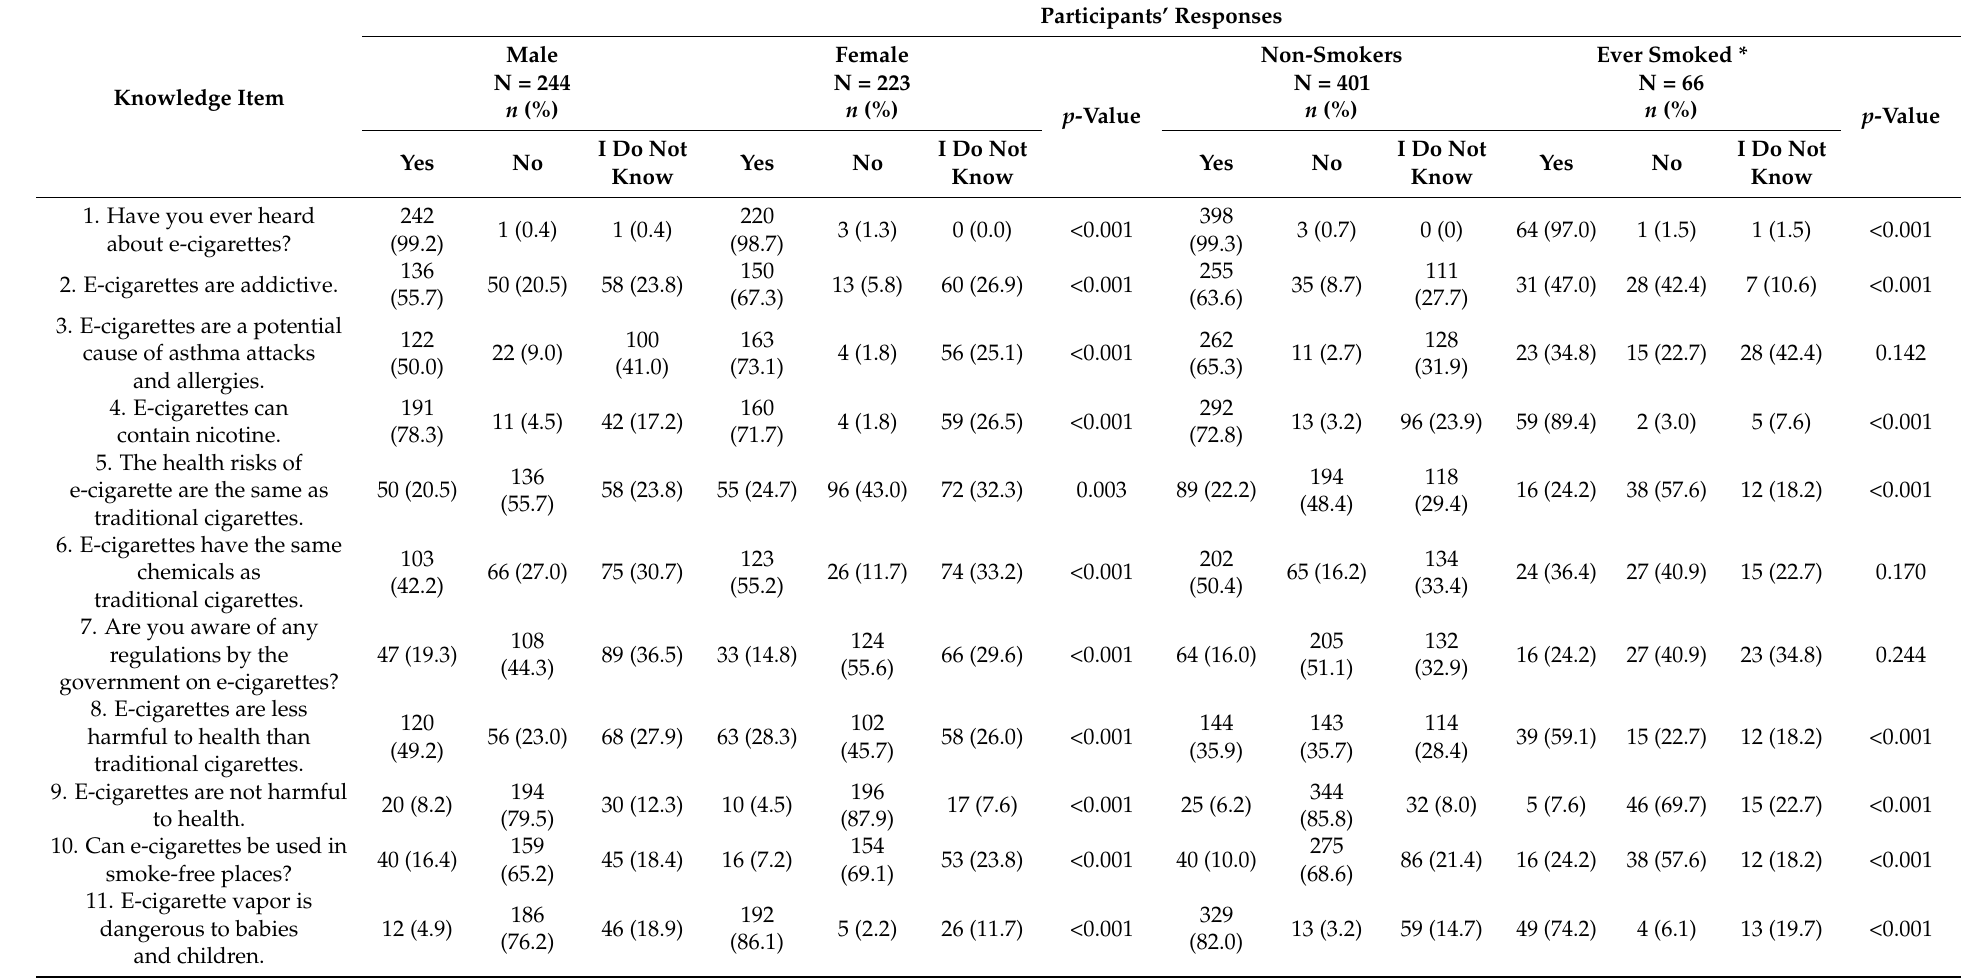
Table 3. Knowledge regarding e-cigarettes among first-year university students according to gender and smoking